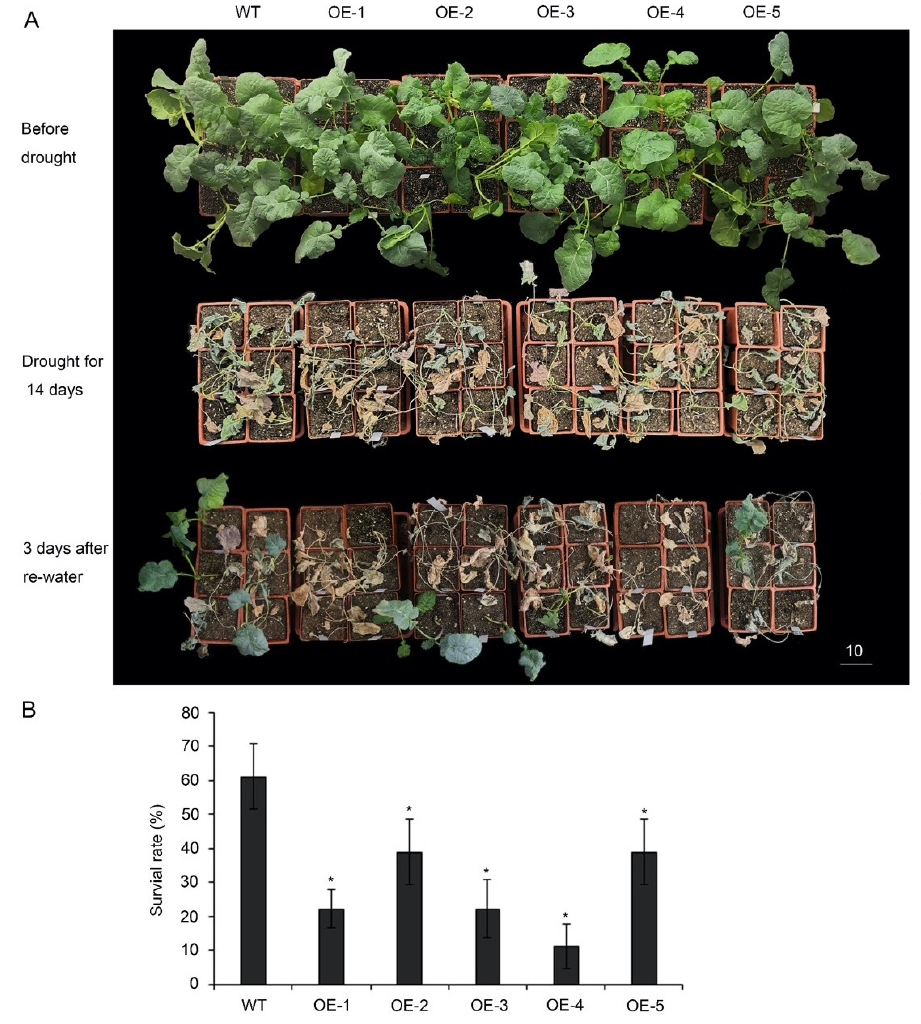
Figure 4. Drought resistance testing of p35S::BnA.JAZ5 plants at the five-leaf stage. ( A ) Drought resistance assay of five overexpressing lines. ( B ) Survival rates of five overexpressing lines after 3-day recovery from drought stress treatment. WT, accession K407. OE-1, OE-2, OE-3, OE-4 and OE-5, p35S::BnA.JAZ5 plants. Asterisks indicate significant differences between wild-type and p35S::BnA.JAZ5 lines ( p < 0.05, Student’s t -test). Scale bar, 10 cm.